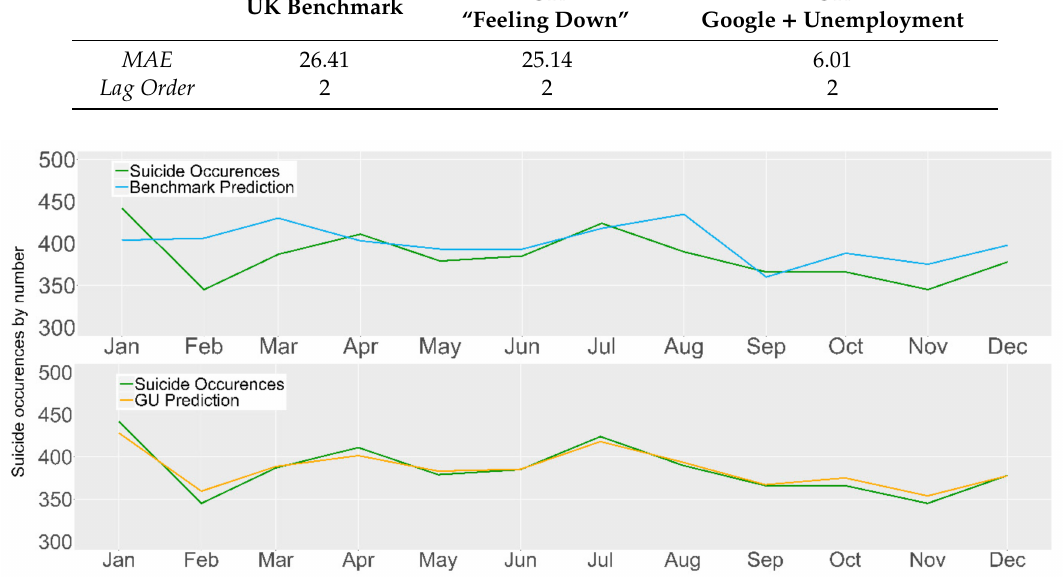
Figure 5. UK model performance in 2014 using the benchmark and Google + Unemployment